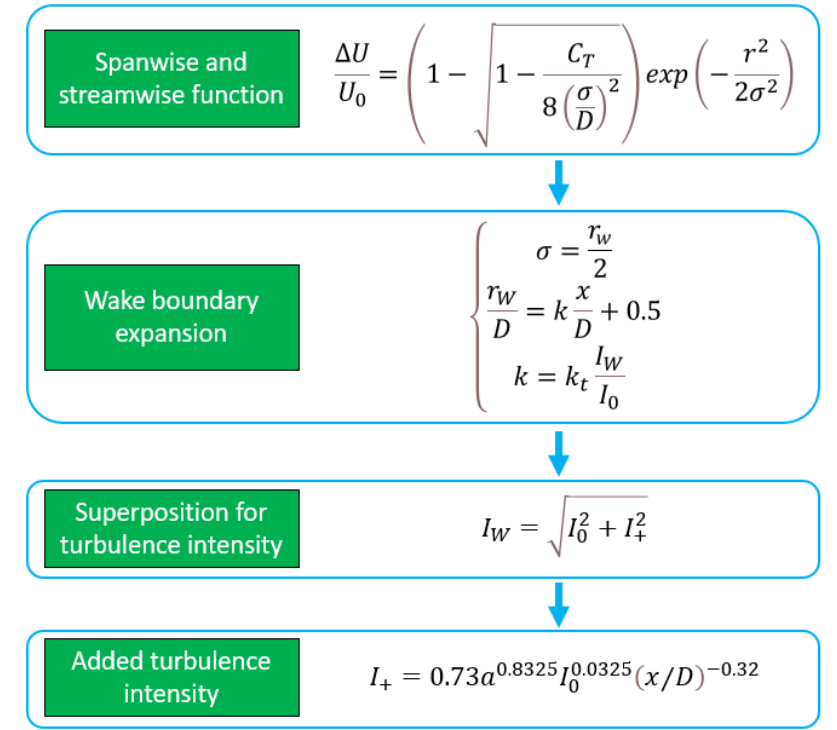
Figure 4. An example of the combined wake model.